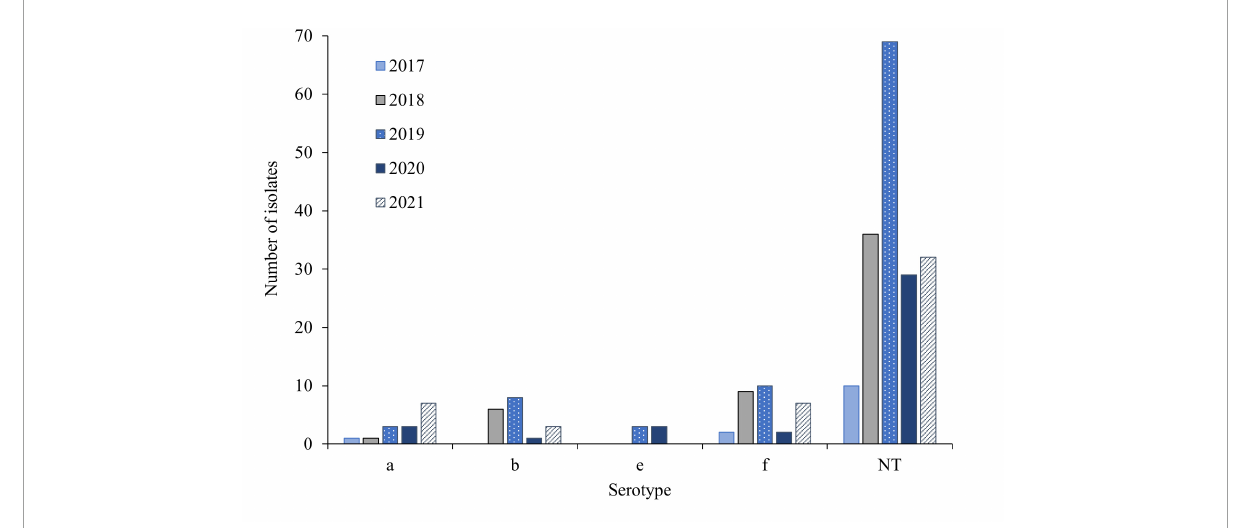
FIGURE3 Number of Hi serotypes per year in 245 invasive Haemophilus influenzae isolates from Norway 2017–2021.